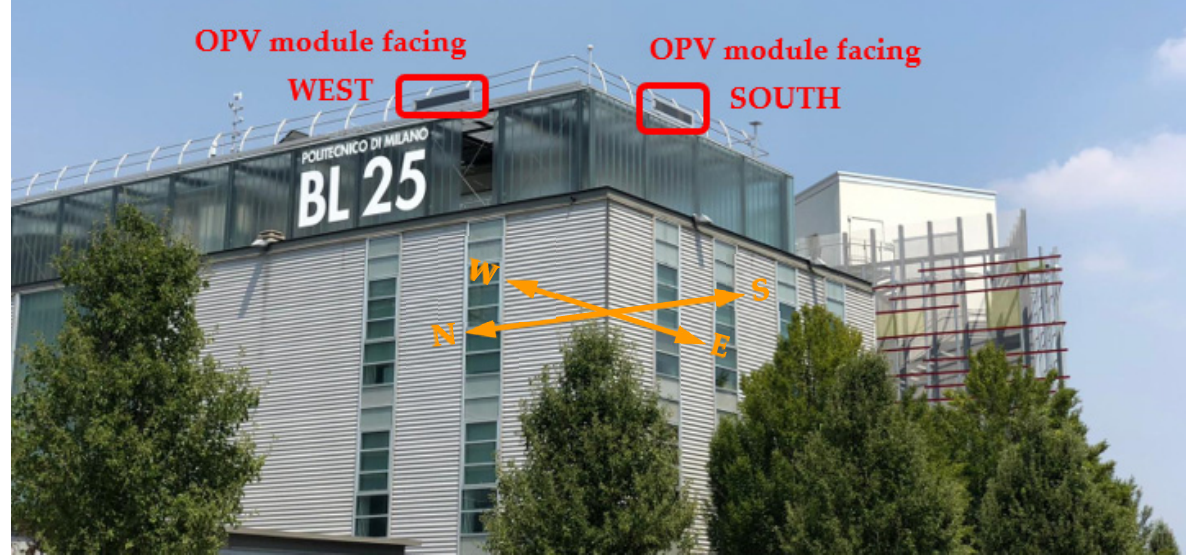
Figure 3. OPV modules installed at the SolarTechLab. The cardinal directions are indicated qualitatively.